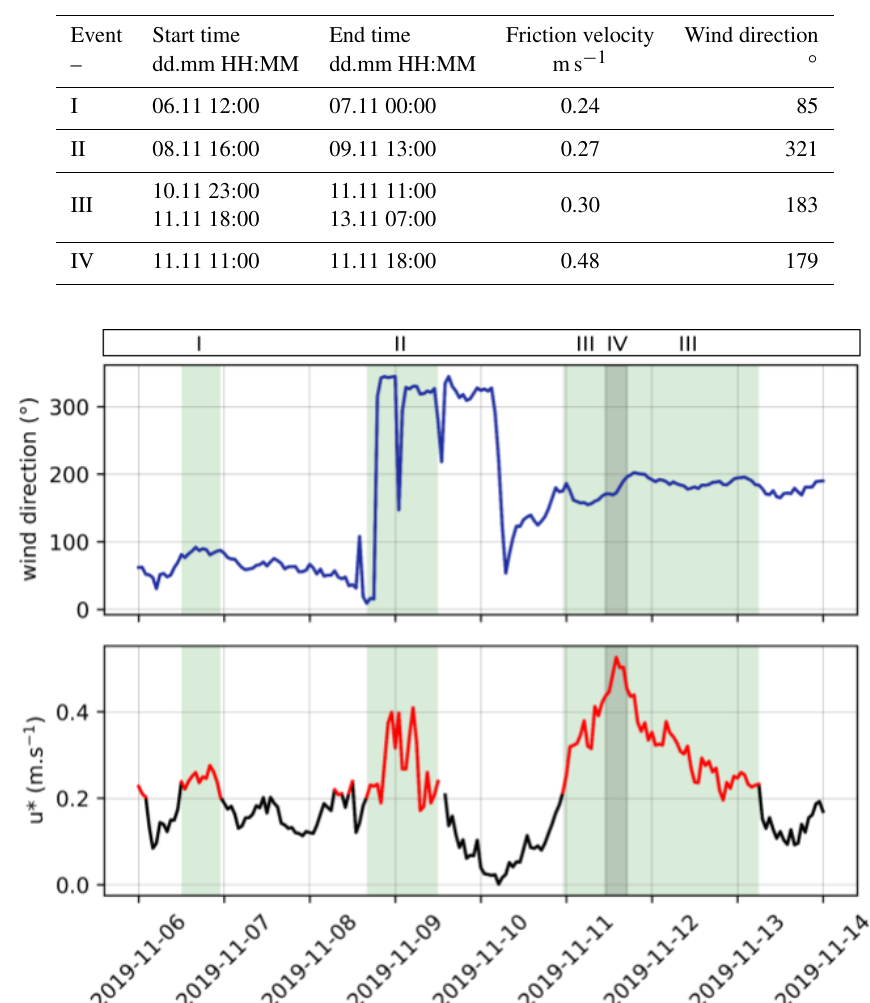
Table 1. Snow transport and precipitation events identified during the period between the successive laser scans (2019).